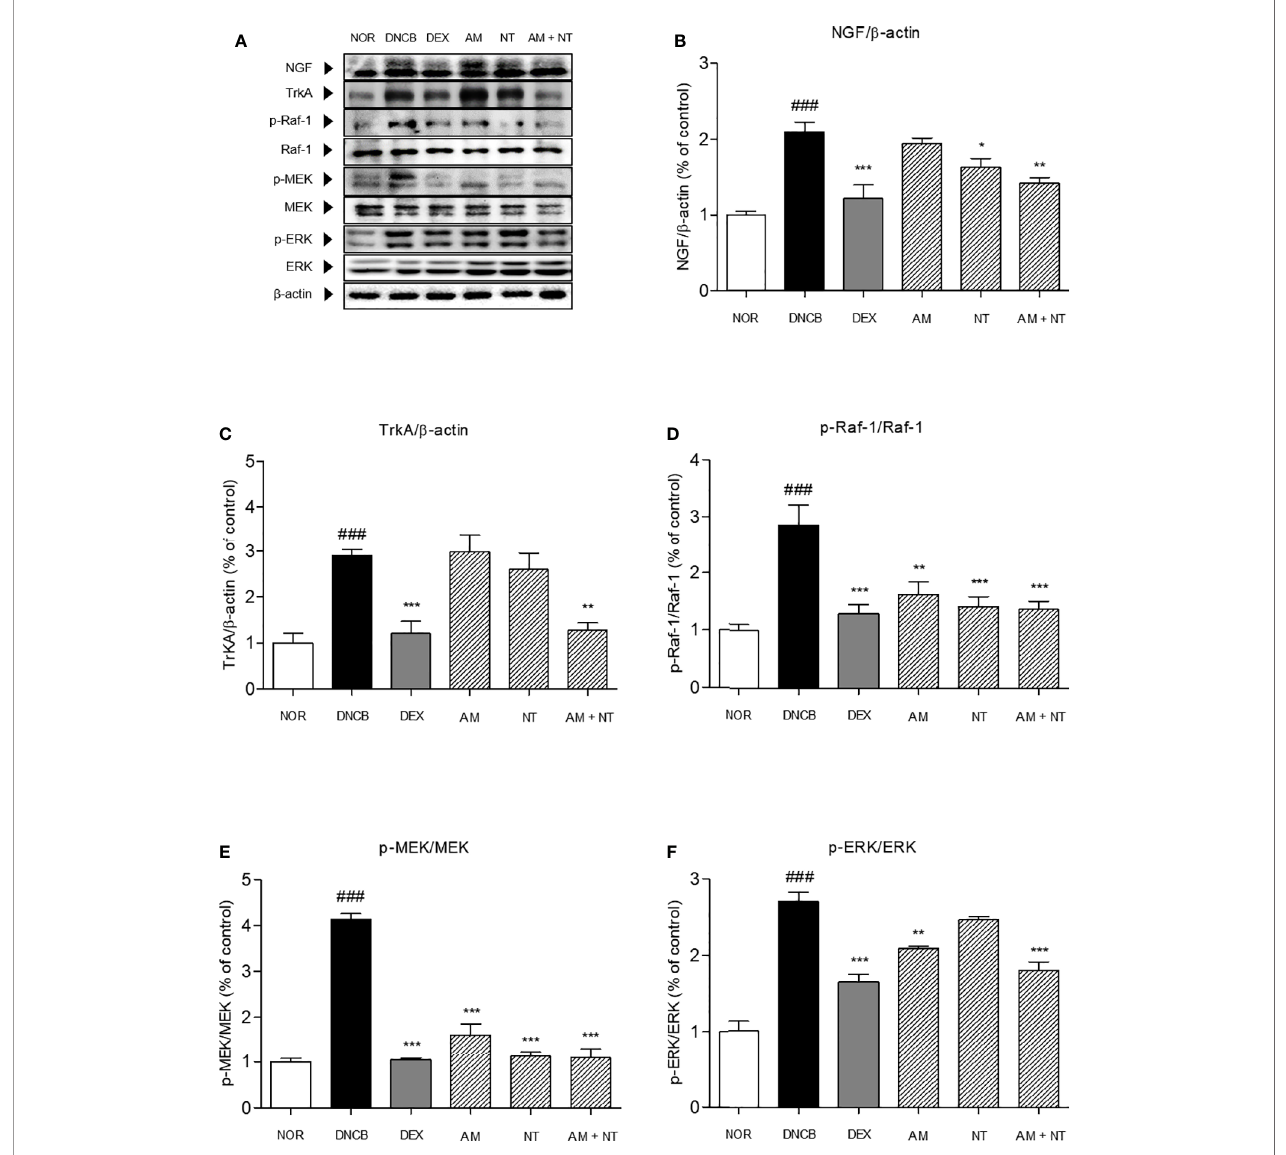
FIGURE 4 | Effects of AM, NT, and a mixture of AM and NT on NGF-TrkA signaling related factors with allergic contact dermatitis skin lesions. (A) The expressions of NGF-TrkA signaling related factors, such as (B) NGF, (C) TrkA, (D) Raf-1, (E) MEK, and (F) ERK were determined on the dorsal skin by Western blot analysis. Data were presented as means ± S.E.M (n = 5). ### p < 0.001 vs. NOR; * p < 0.05, ** p < 0.01, and *** p < 0.001 vs.